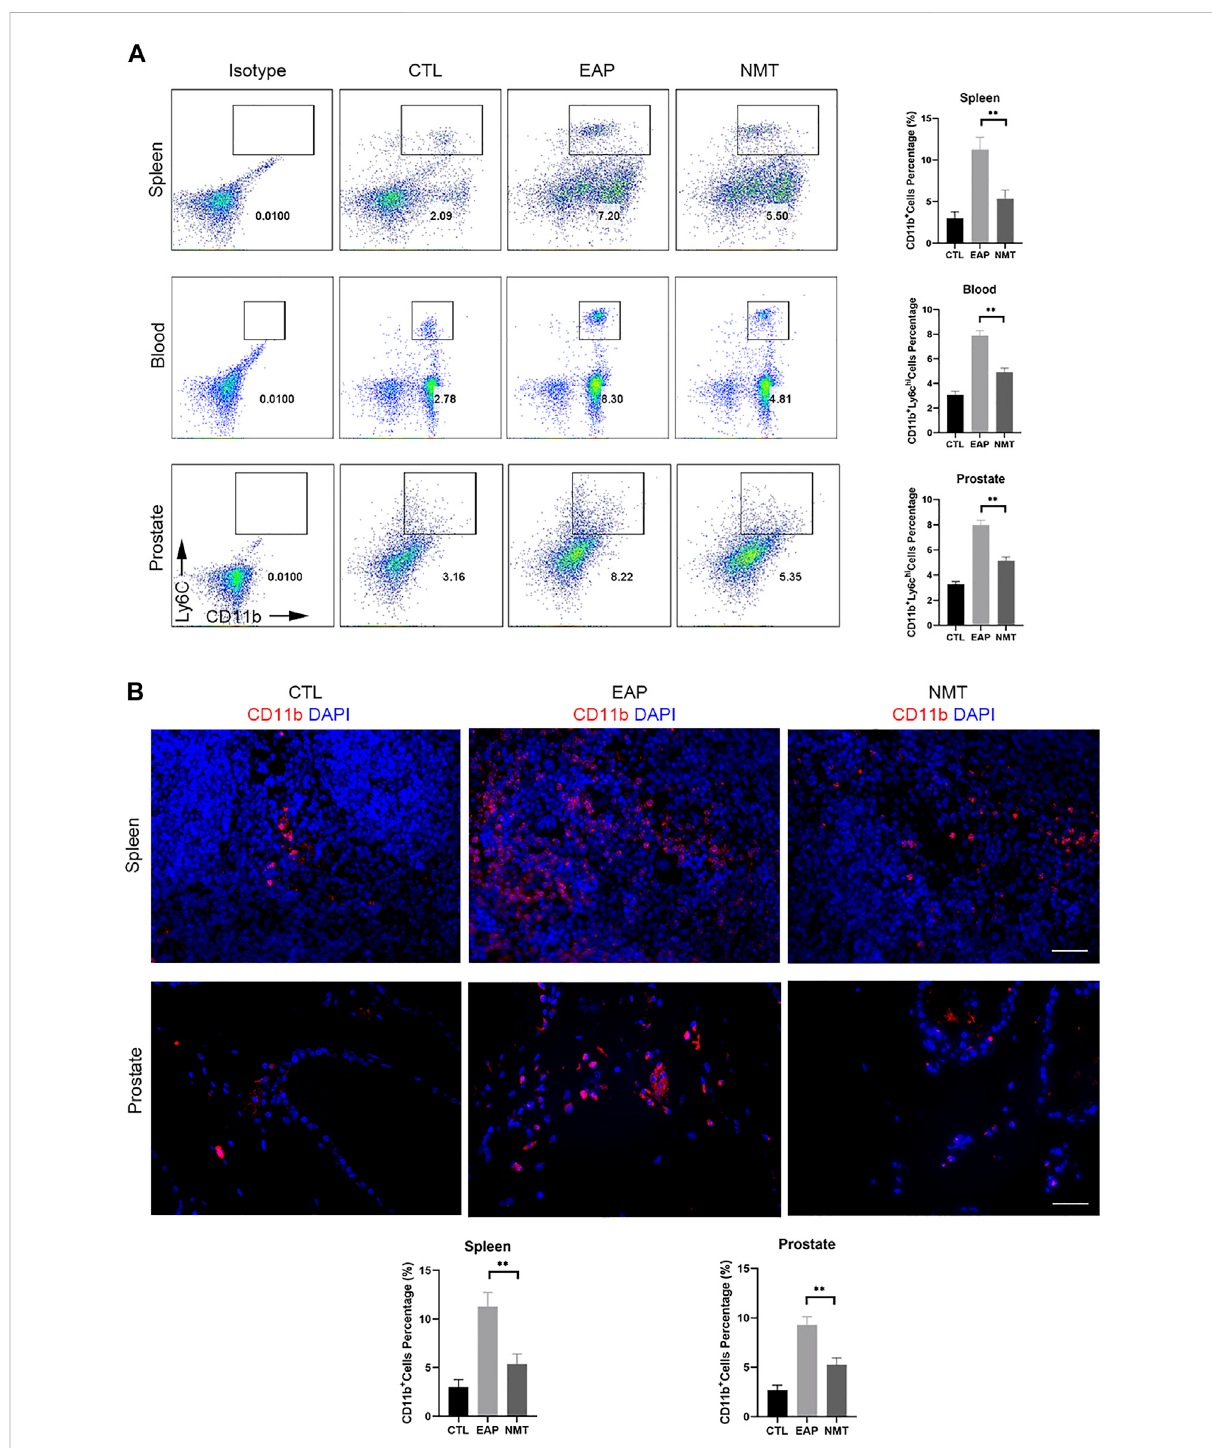
FIGURE 5 Changes in systemic and local immune responses in mice after Ningmitai treatment. (A) Flow cytometry analysis showing the proportion of CD11b + Ly6C high immune cells in the spleen, blood, and prostate, and statistical analysis of the results in the CTL, EAP, and NMT groups n = 6. CTL = control; EAP = experimental autoimmune prostatitis mice; NMT: Ningmitai-treated mice. (B) Immuno fl uorescence experiments showed the expression of CD11b + immune cell in fi ltration and statistical analysis of the results in the CTL, EAP, and NMT groups. n = 6. (*: p < 0.05; **: p <